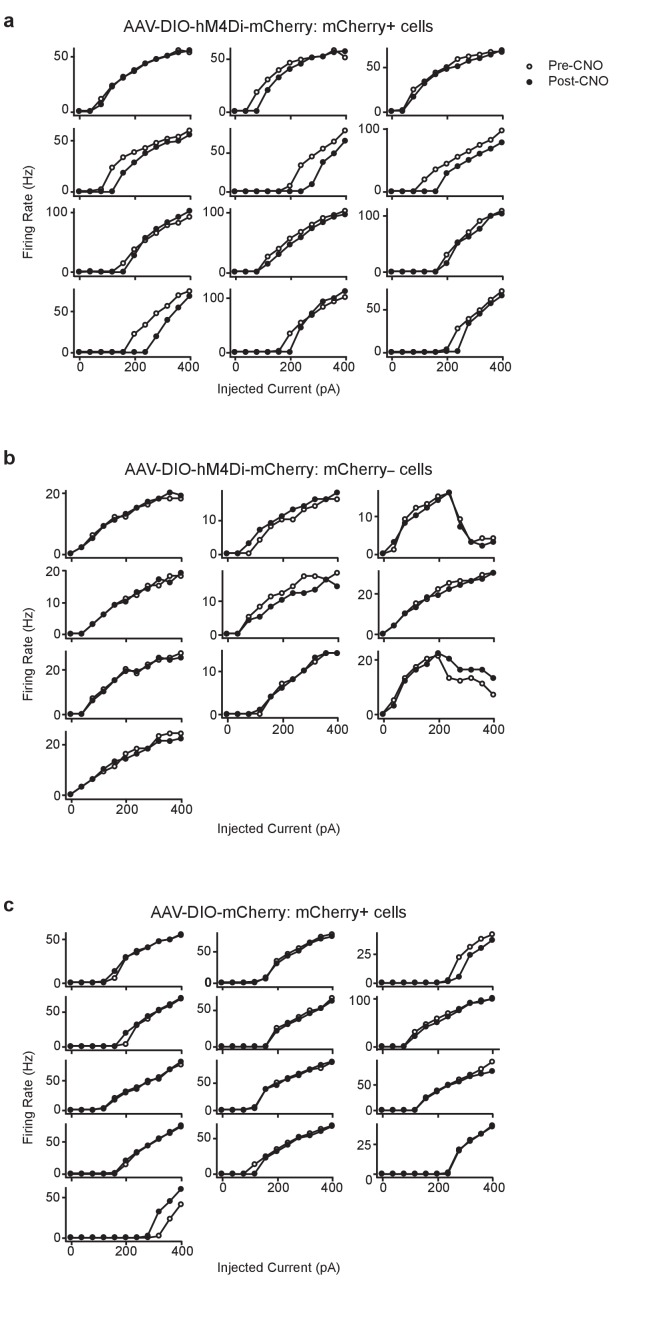
Decrease in firing rate was observed Post-CNO in (a) hM4Di-mCherry+cells (n = 12), but not in (b) hM4Di-mCherry- cells (n = 10), or (c) mCherry+cells (n = 13).Traces are firing rates over current steps of all individual cells included in the summary data shown in Figure 1e.